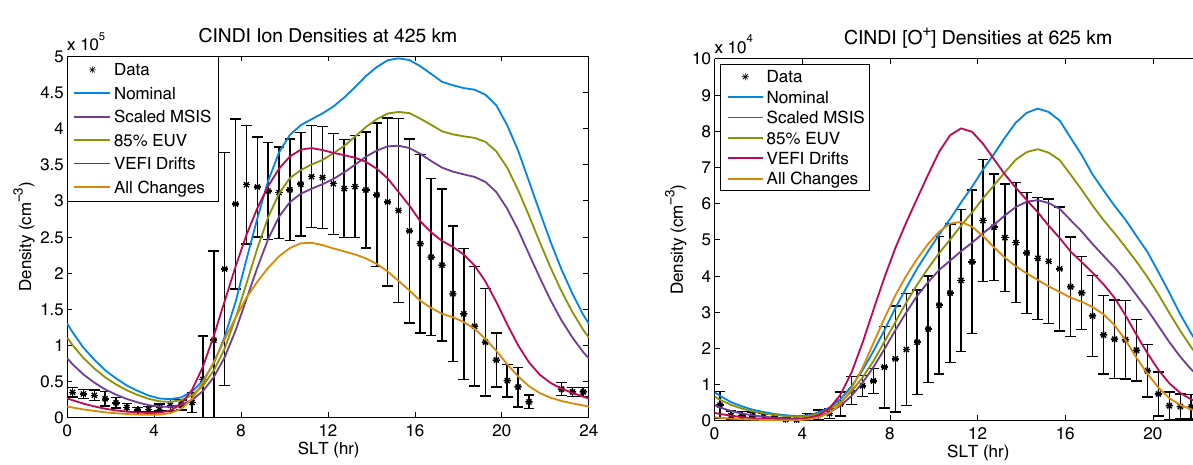
O + density as measured by CINDI at 625 km altitude as a function of local time. The Fig. 5. The average colored lines represent the predicted densities based on the different SAMI2 runs. The vertical bars represent standard deviations.